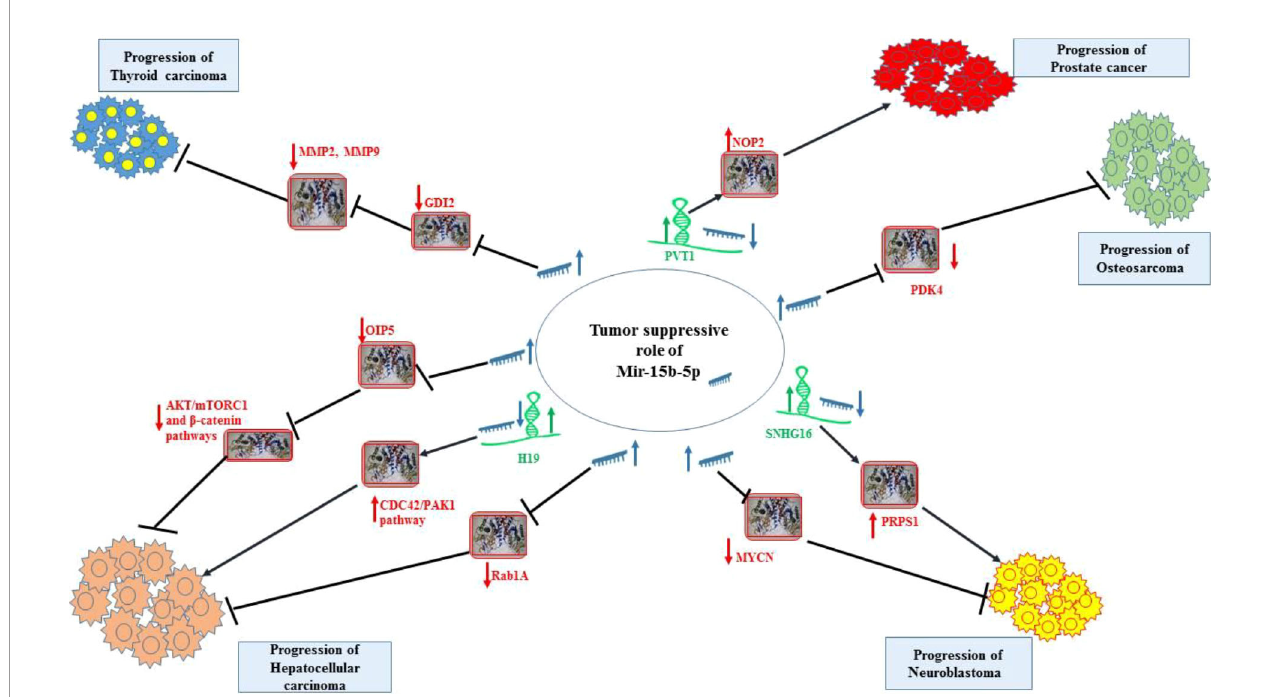
FIGURE 2 | Tumor suppressor role of miR-15b-5p in thyroid cancer, hepatocellular carcinoma, neuroblastoma, osteosarcoma and prostate cancer. Detailed information about the conducted experiments is shown in Table 1